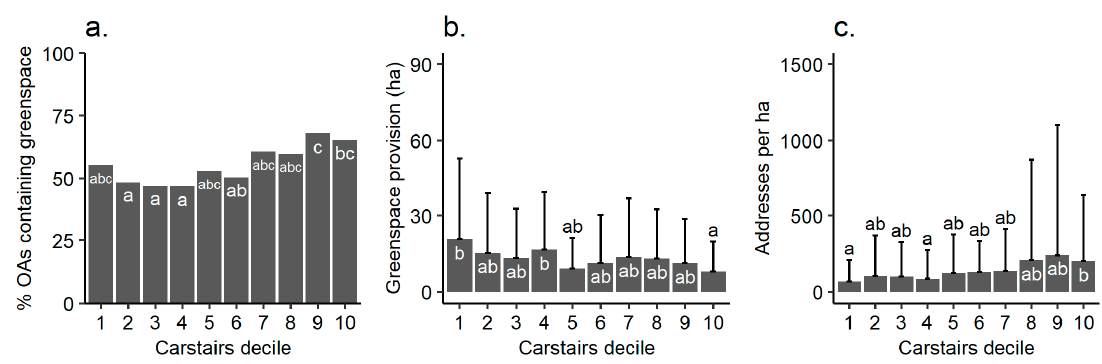
Figure 4. Variation in greenspace accessibility (a), provision (b) and population pressure (c) by decile of Carstairs Deprivation Index, quantified at the OA scale according to areal coverage by greenspaces. Positive error bars show one standard deviation. Different letters indicate significant differences among deciles, e.g., ‘a’ indicates a decile that is significantly different to ‘b’ but not different to other deciles marked ‘a’; while a decile marked ‘ab’ is not significantly different to those marked either ‘a’ or ‘b’ (Tukey’s test at α = 0.05).